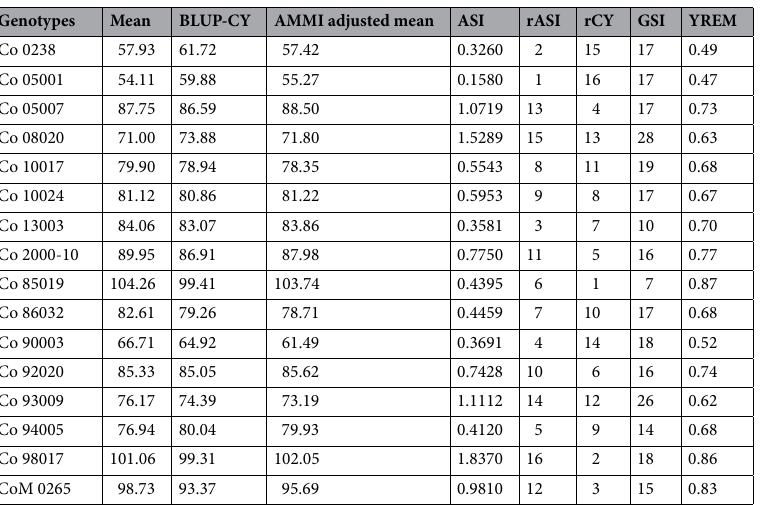
Table 3. Comparative mean performance, BLUP, AMMI stability indices for cane yield (t/ha) under drought stress in sugarcane. BLUP best linear unbiased prediction, CY cane yield (t/ha), ASI AMMI stability index,